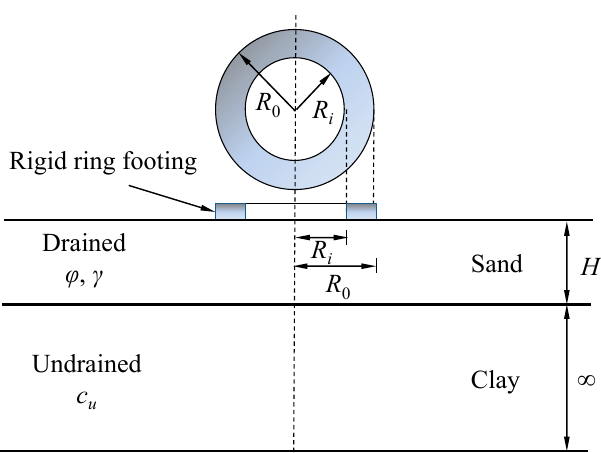
Figure 1. Problem definition of a rigid ring footing on sand overlying clay.